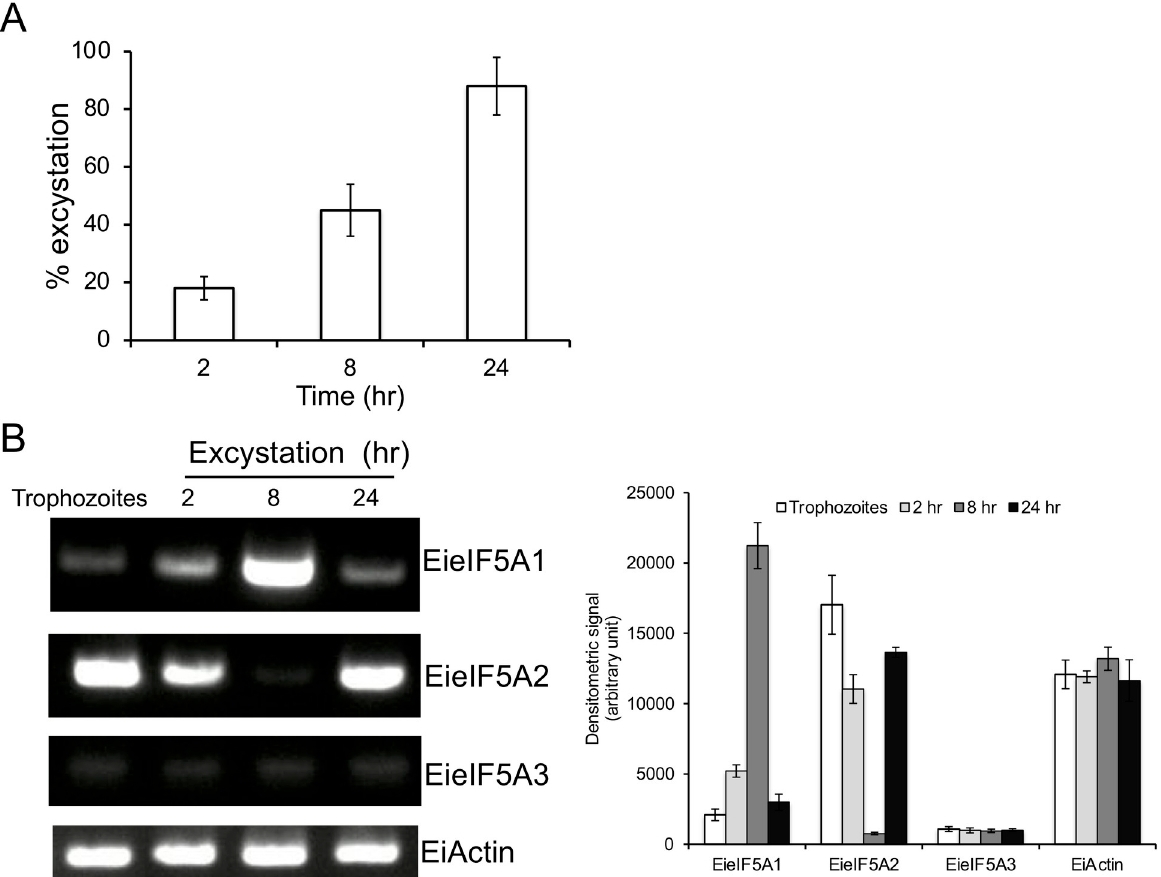
Fig 9. Steady state transcript levels of EieIF5A isoforms during excystation. (A) Kinetics of excystation. Cysts were incubated at the indicated times, cysts and trophozoites were harvested and the excystation percentage was determined. The excystation efficiency was determined by counting trophozoites and cysts in a haemocytometer and experiments were performed in duplicate. Data shown are the means ± standard deviations of two independent experiments. (B) Semi-quantitative RT-PCR analysis of EieIF5A1 , EieI5FA2 , EieIF5A1 and EiActin genes during excystation. cDNA from 4 time points during excystation was subjected to 30 cycles of PCR using specific primers for eIF5A1 , eI5FA2 , eIF5A3 , and actin genes. Actin gene served as a control. PCR from samples without reverse transcription served as controls to exclude the possibility of genomic DNA contamination. The densitometric quantification of the bands, shown in the right graph, was performed by Image J software, and the expression level of EieIF5A1 , EieIF5A2 , and EieIF5A3 and EiActin was expressed in arbitrary units.